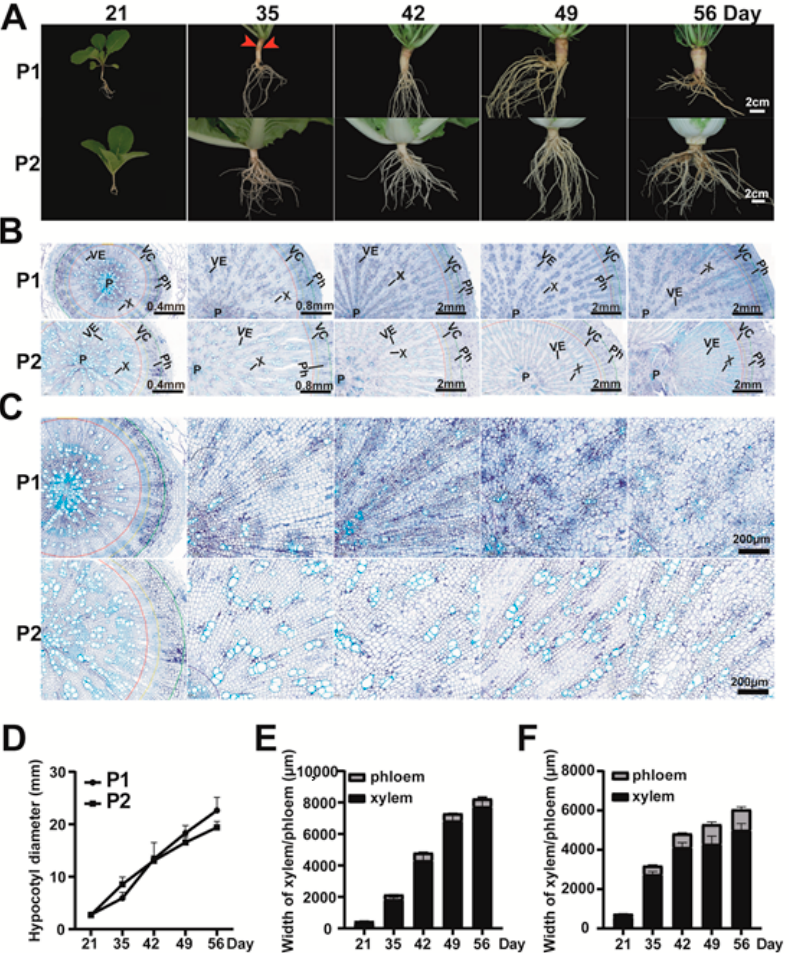
Figure 2. Phenotypic and cytological observation of P1 and P2. ( A ) Phenotypic observation of the root and hypocotyl of P1 (turnip) and P2 (Chinese cabbage) at 21, 35, 42, 49, and 56 days after germination (DAG). Red arrows represent the cortex splitting phenotype. Three biological replicates were observed for each time point. Bar, 2 cm; ( B ) Bottom part of hypocotyls from P1 and P2 at 21, 35, 42, 49, and 54 DAG. P, pith; VE, vessel; X, xylem; Ph, phloem; VC, vascular cambium; ( C ) Xylem cells of P1 and P2 at 21, 35, 42, 49, and 54 DAG. Bar, 200 µ m; ( D ) The hypocotyl diameter of P1 and P2 plants in different development stages; ( E , F ) The xylem width and phloem width of hypocotyls from P1 ( E ) and P2 ( F